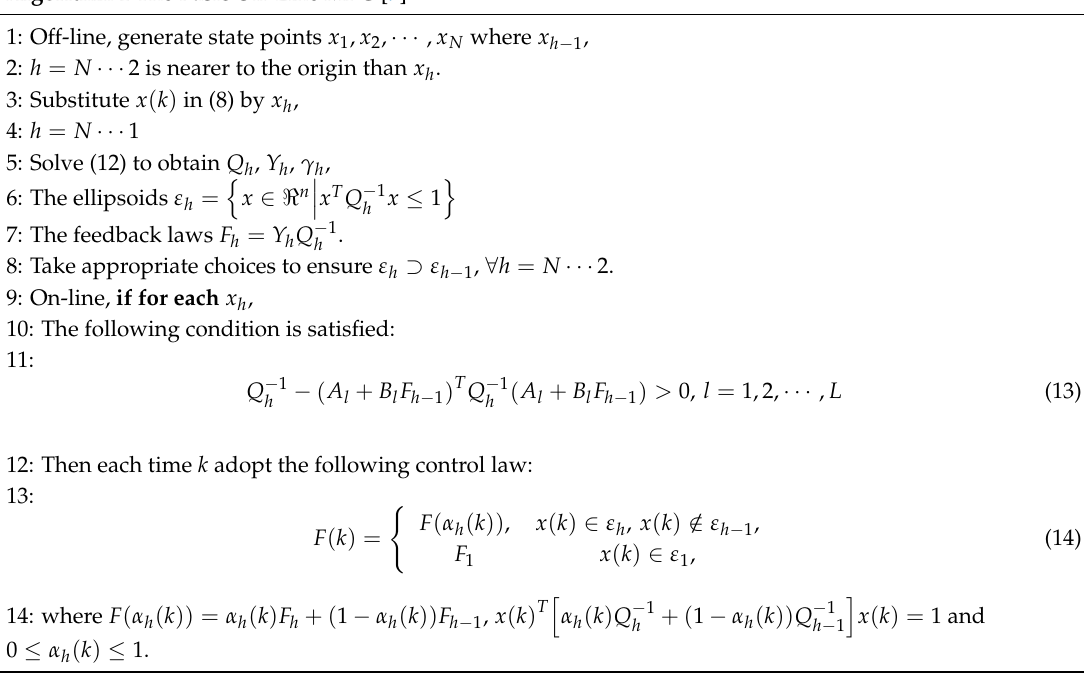
Algorithm 1 The Basic Off-Line MPC